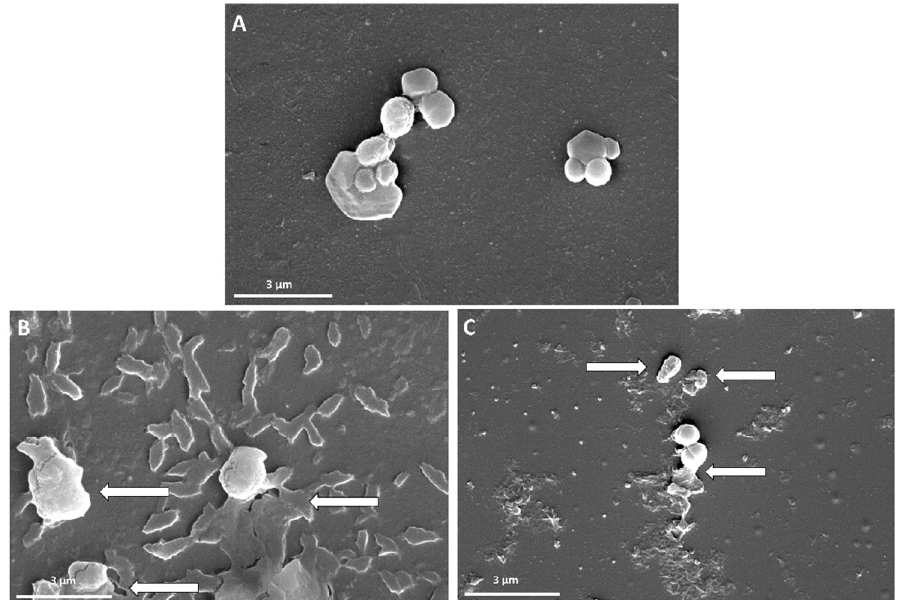
Figure 8. FE-SEM images of MRSA before and after exposure to the GO-PEG-antibiotics, ( A ) MRSA without treatment with GO-PEG-antibiotic, ( B ) MRSA treated with GO-PEG-PEN, ( C ) MRSA with GO-PEG-OXA.